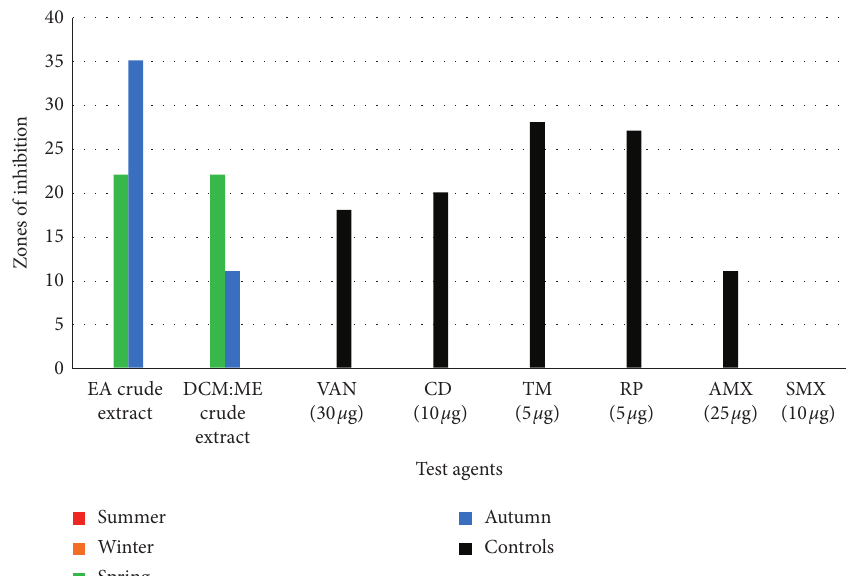
Figure 2: Antibacterial activity of ethyl acetate (EA) and dichloromethane: methanol (DCM :ME) crude extracts against MRSA.